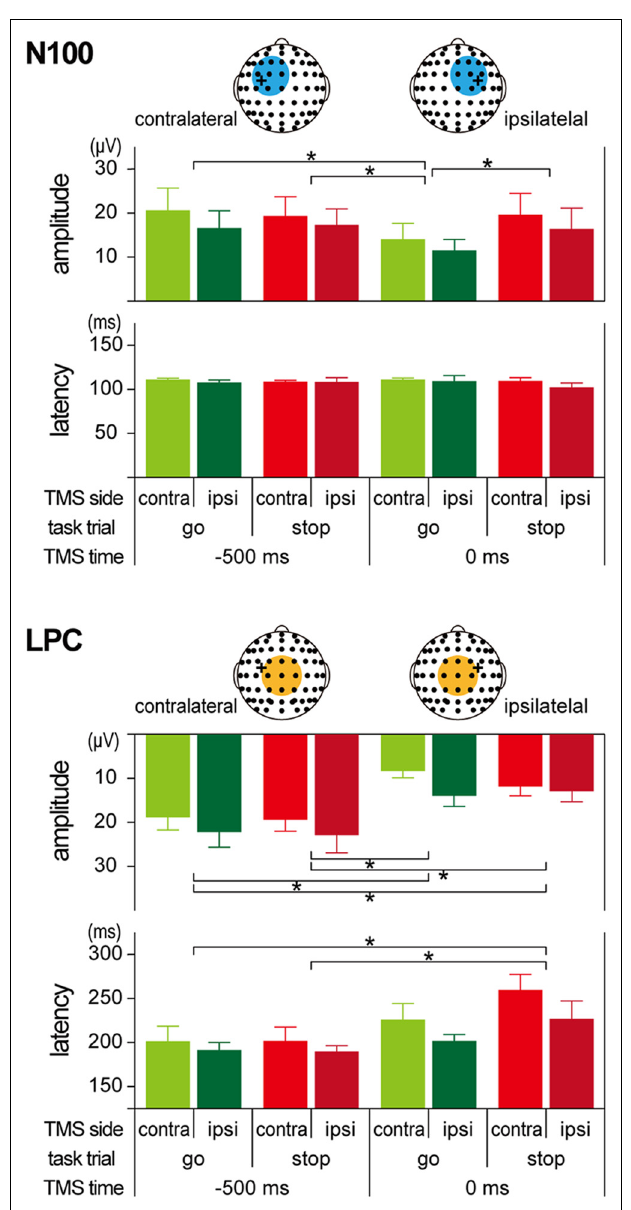
FIGURE 6 |Amplitudes and latencies of long-latency components in TMS-evoked potential (TEP). Group means ( ± SE) of N100 (upper) and LPC (lower) amplitudes and latencies during go/stop tasks with contralateral and ipsilateralTMS at − 500 and 0 ms. Light blue and orange circles in the scalp electrode drawings represent regions of interest (ROIs). Error bars show standard error (SE). ∗ p < 0.05; significant difference in post hoc multiple comparisons with Bonferroni corrected paired t